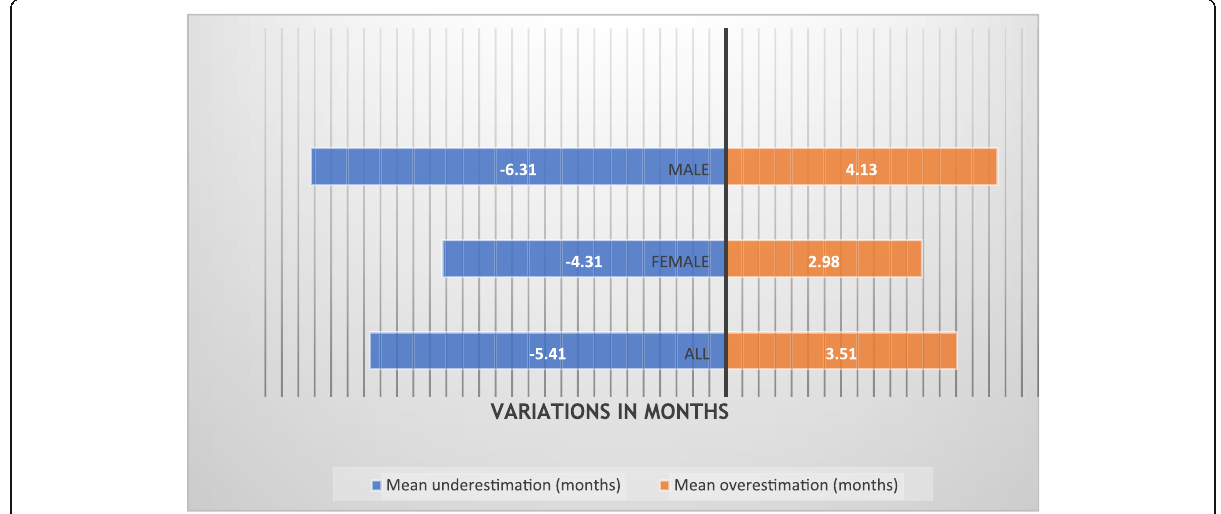
Fig. 3 Graph depicting mean underestimation and overestimation amongst our subjects (in